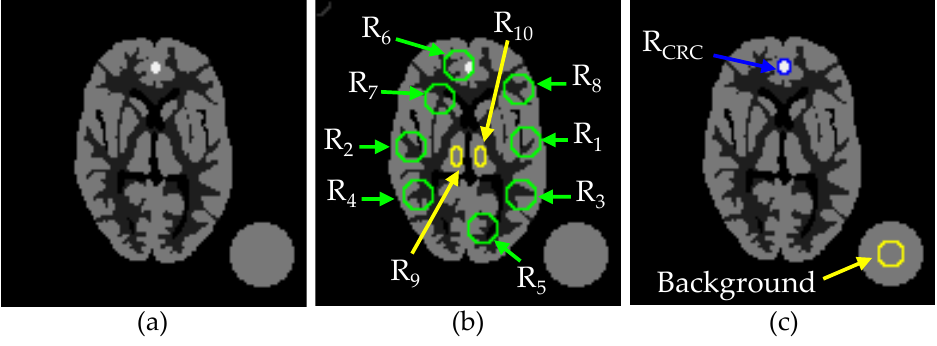
Figure 6. Hoffman brain phantom and ROIs for regional MPE and MCRC measures: ( a ) phantom; ( b ) ROIs for regional MPE; ( c ) ROI for CRC with respect to background.